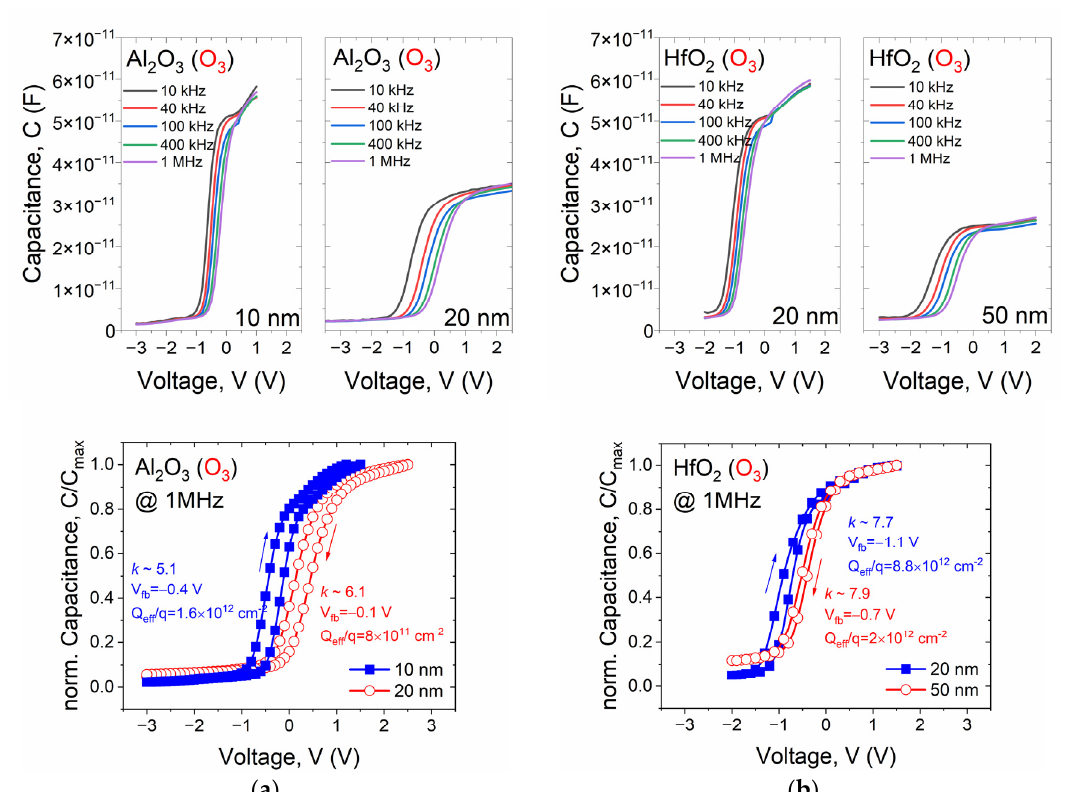
Figure 8. Comparison of representative high-frequency C-V characteristics of MIS structures with ALD gate dielectric films deposited with O 3 precursor: ( a ) Al 2 O 3 and ( b ) HfO 2